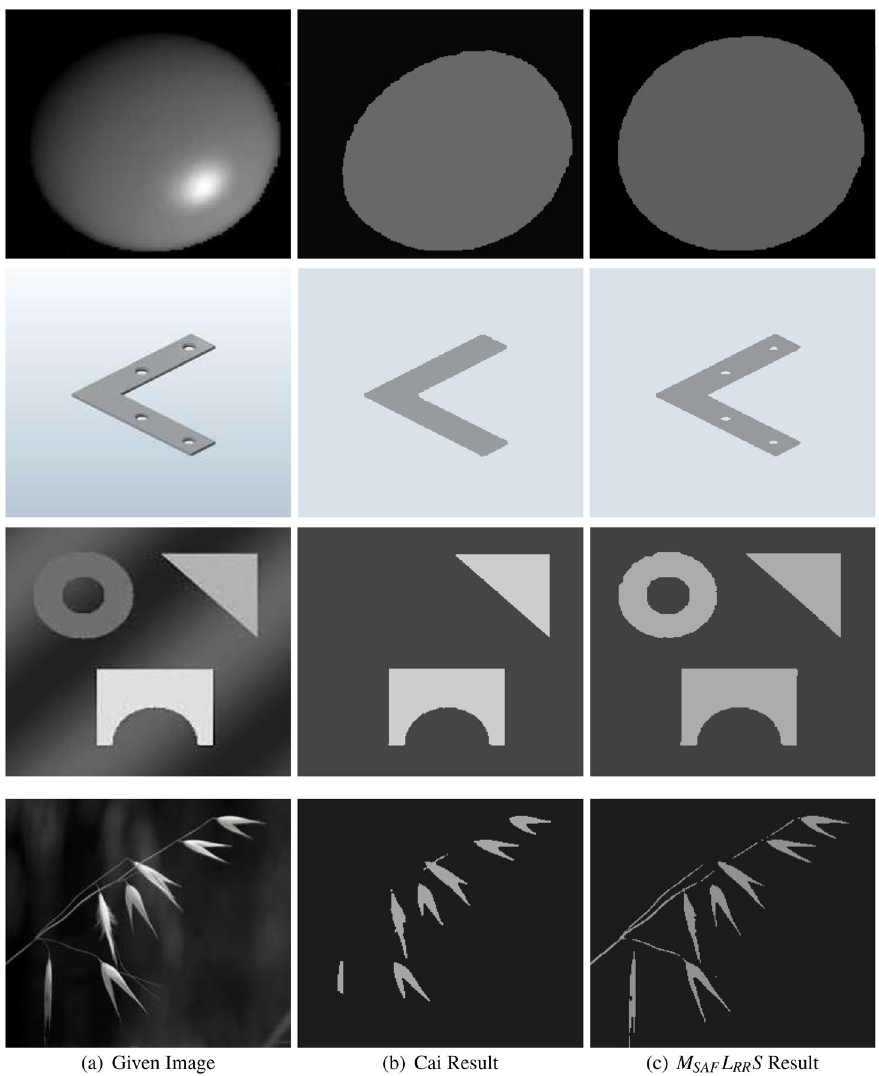
Figure 7. A comparison of the Cai et al. 14 and the suggested approach on four dissimilar images that are suffered with slender and grievous intensity inhomogeneity 33 . The first column represents given images, however the second and third columns display the segmented results of the Cai et al. 14 and proposed models, respectively. Moreover, the parameters used for M SAF L RR S model are: (c) (cid:31) 2 = 10 , k = 30 , (f) (cid:31) 2 = 100 , k = 30 , (i) (cid:31) 2 = 50 , k = 35 and for (l) (cid:31) 2 = 200 , k = 5